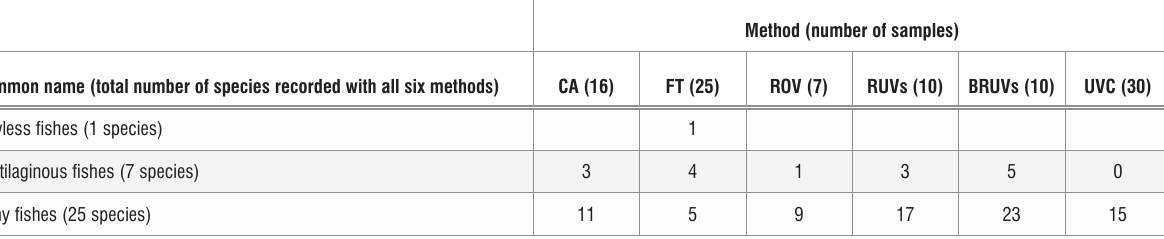
Method (number of samples)